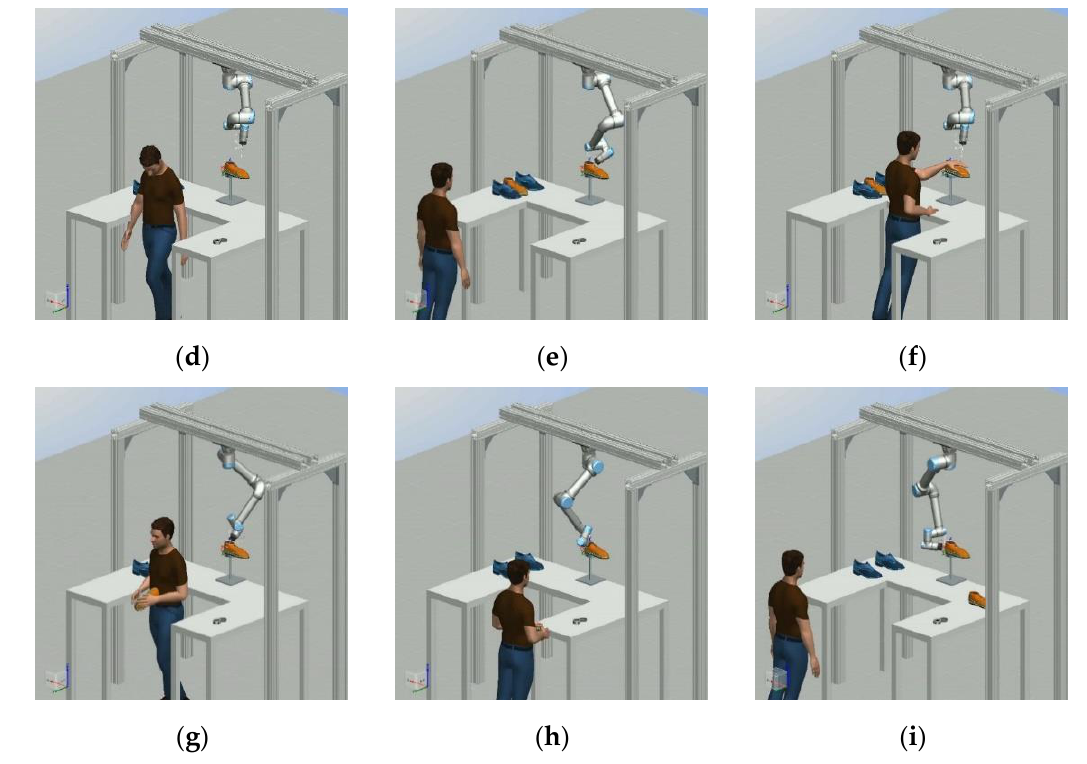
Figure 13. Simulation of the polishing process.